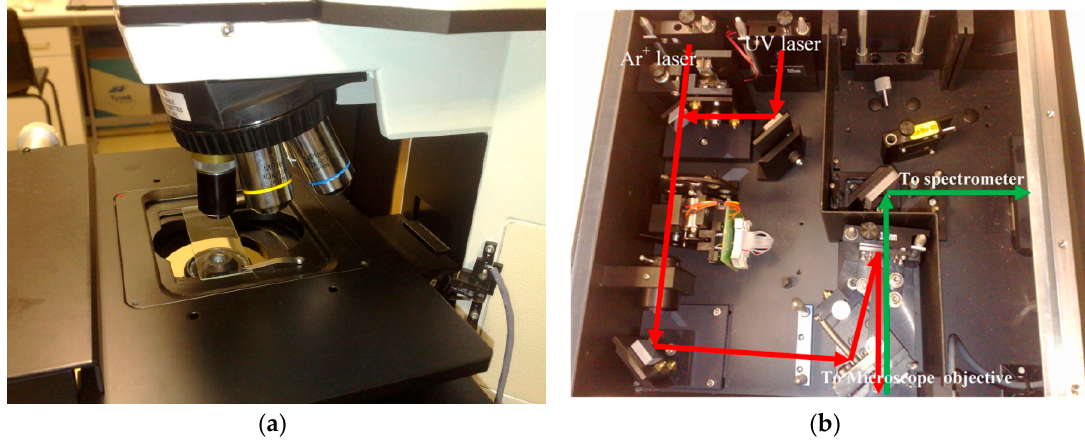
Figure 11. ( a ) Microscope lenses attached to the LabRam ® HR800 System. The sample under test typically sits on a glass microscope slide below the objective lens. ( b ) Internal light paths for LabRam ® HR800 System. The red line shows the path of the laser beam, while the green line shows the path of the Raman scattered beam.